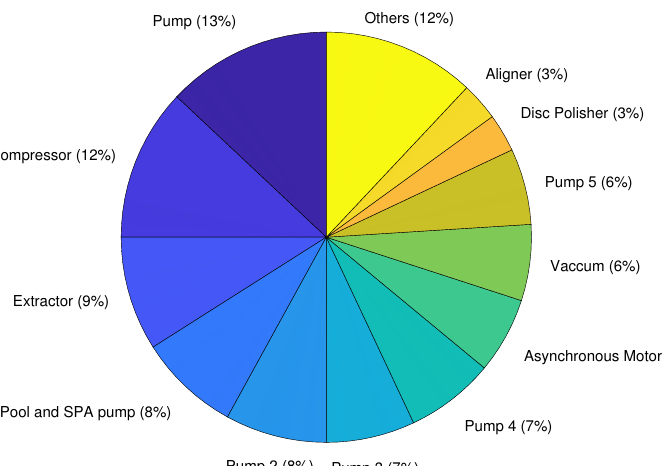
Figure 6. Energy use share by